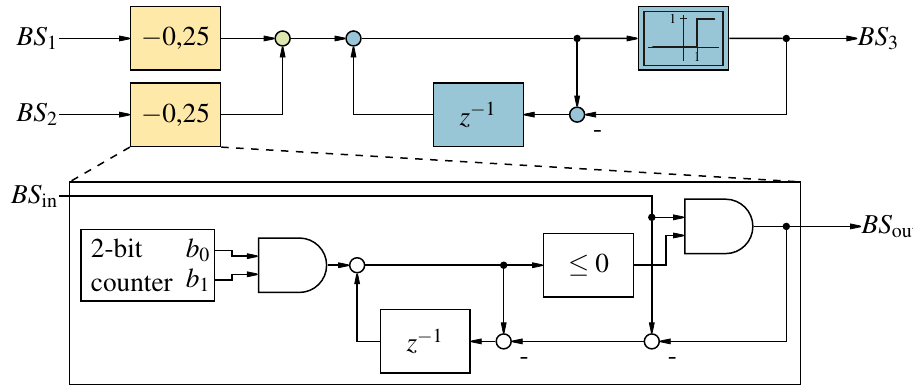
Figure 8. Addition of two bit-streams using bit-stream modification with detailed description of the block 0.25. −